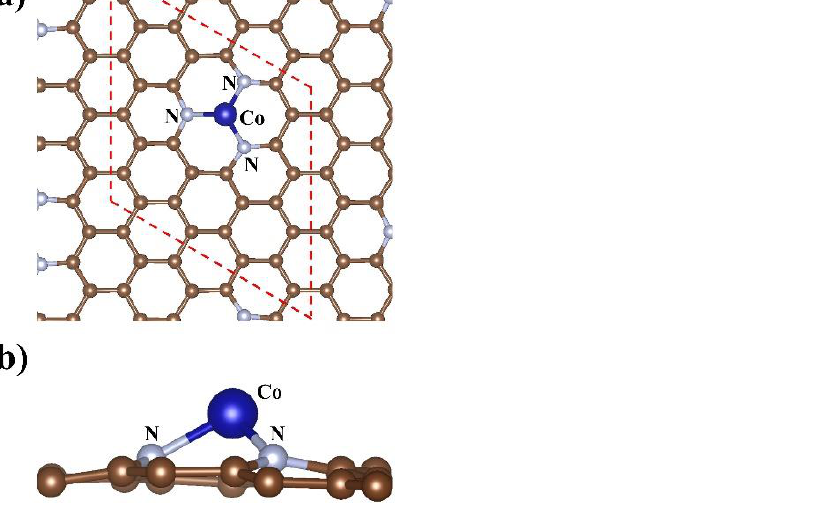
Figure 1. The ( a ) top view and ( b ) side view of fully optimized configuration of Co/N 3 – gra. The red dotted line in ( a ) denotes the unit cell.